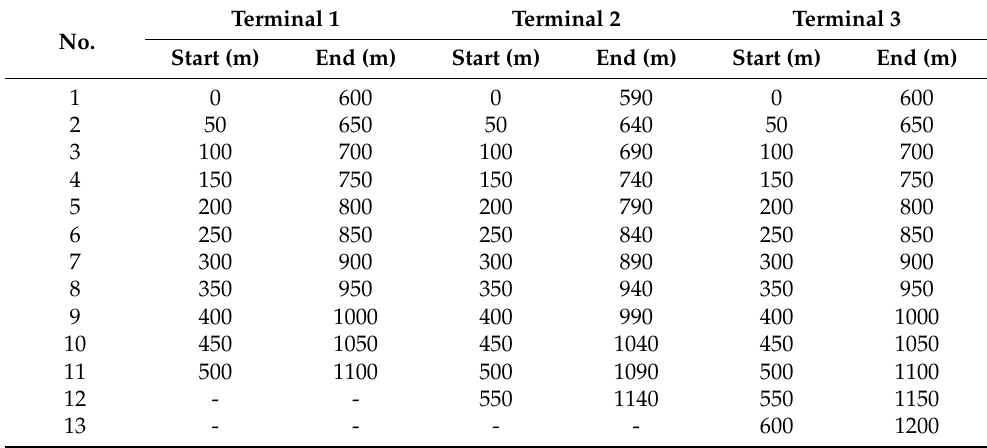
Table 4. The service range of cranes for each terminal.